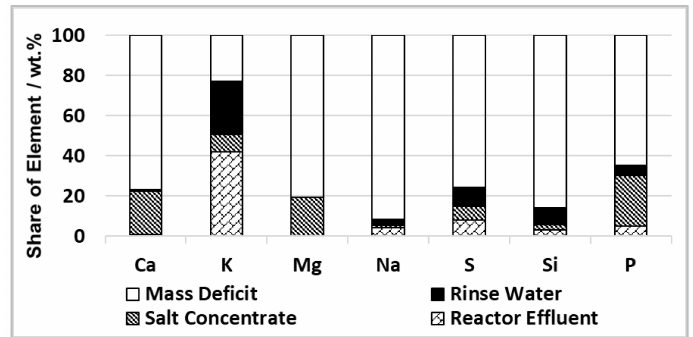
Figure 11. Distribution of salt building elements in the products of experiment 2 (concentration in feed =